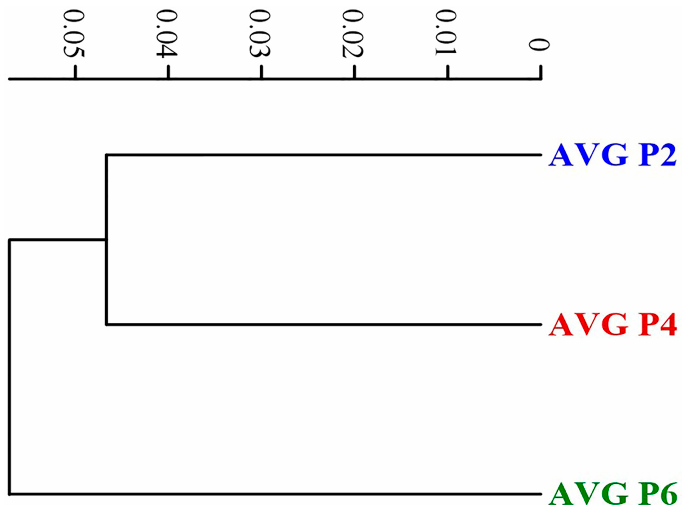
Figure 2. Cluster analysis for FTIR spectra compares three varieties of cassava flour (P2 = Pirun 2, P4 = Pirun 4, P6 = Pirun 6).